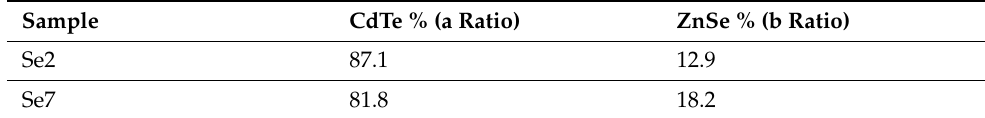
Table 4. The EMA analysis composition of model 3.